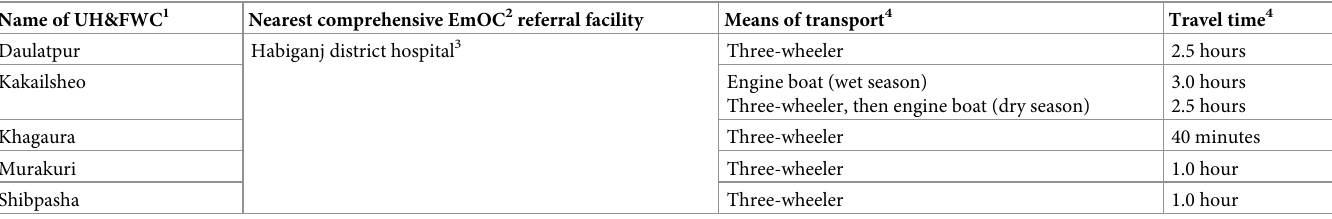
Table 1. Type of transportation and travel time to the nearest comprehensive EmOC referral facility.